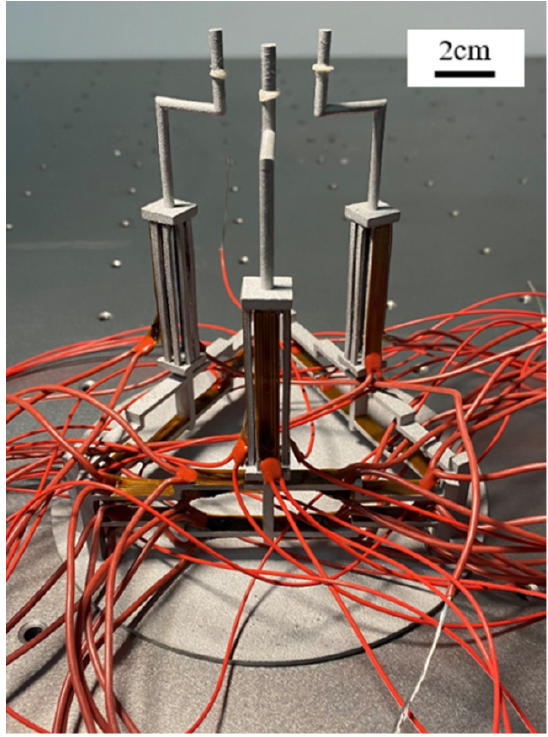
Figure 15. The fabricated 3D microgripper with the Polyimide films.